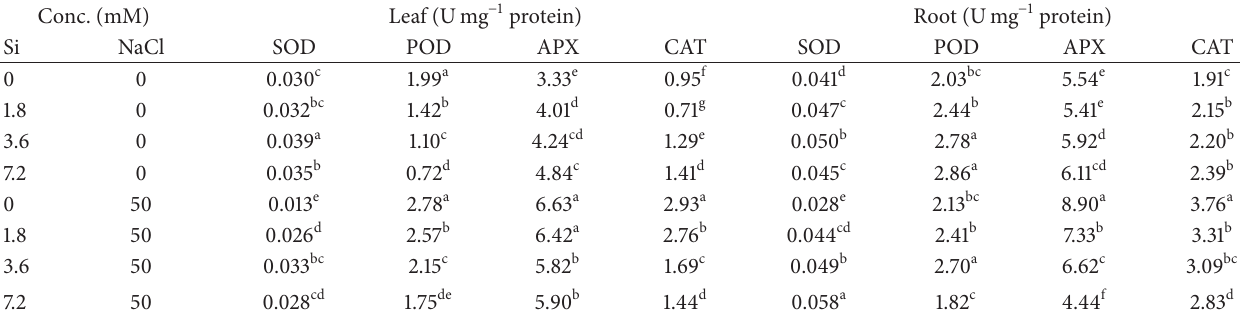
Table 5: Effect of Si and NaCl on antioxidant enzyme activities of A. multiflora .